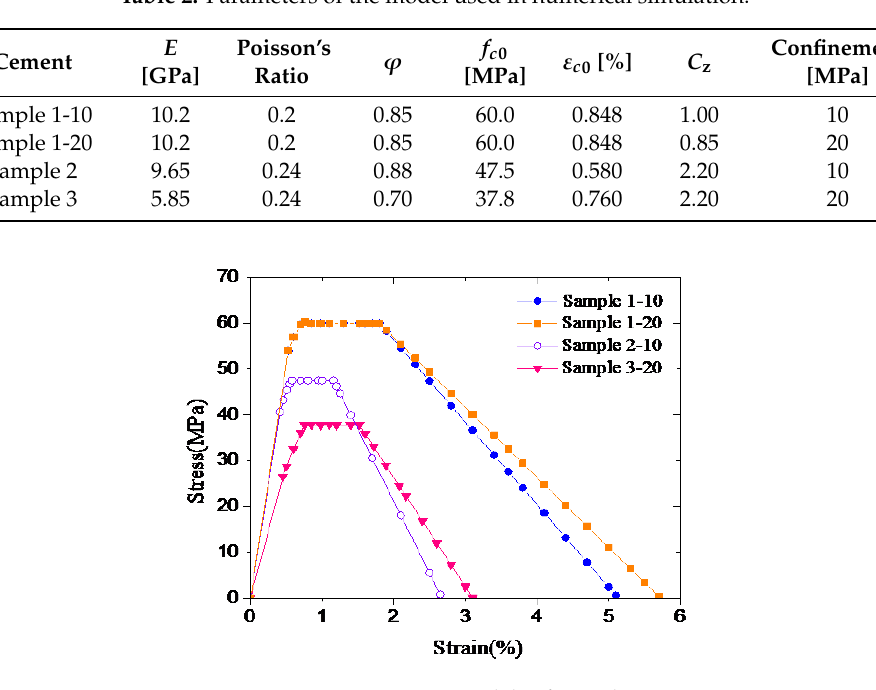
Figure 7. Stress–strain models of samples.